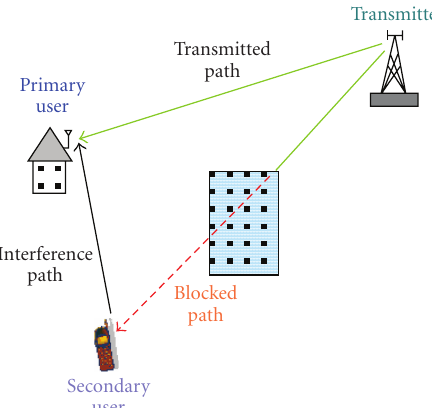
Figure 1: The hidden node problem of a sensing-based cognitive